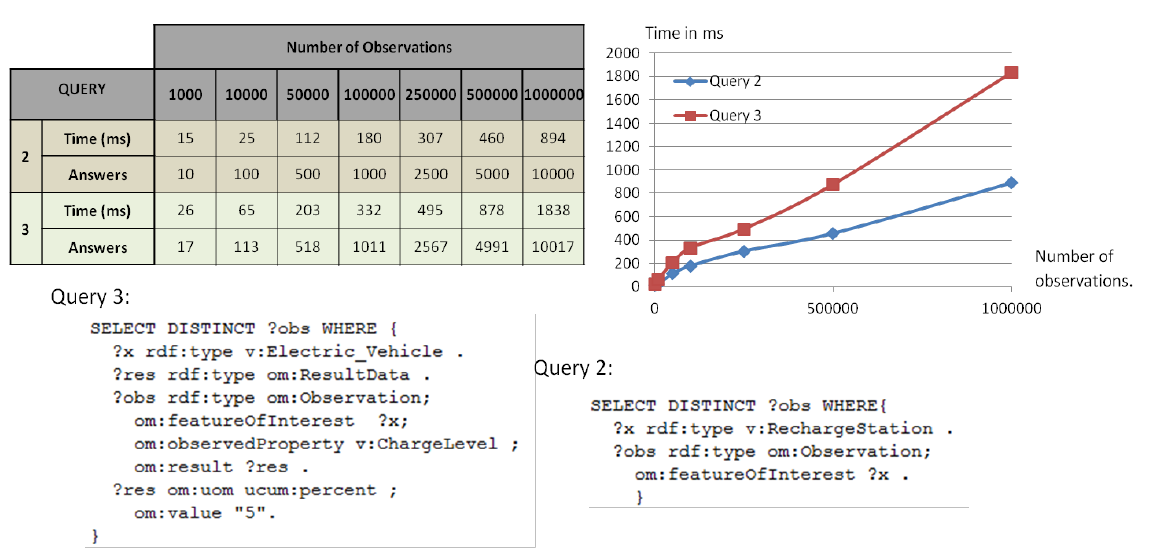
Figure 10. Response times for queries returning a similar number of responses but different amounts of data in the SPARQL